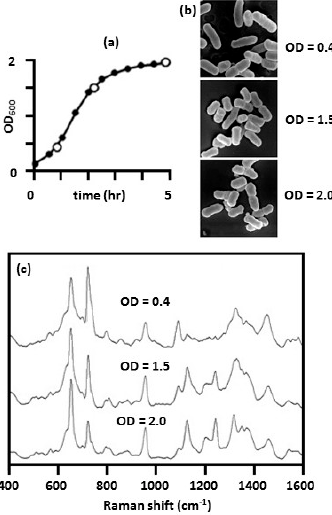
Figure 13. SERS spectra of E. coli obtained at different growth phases [55]: ( a ) plot of optical density at 600 nm (OD 600 ) as a function of growth time, where cells were harvested at OD 600 of 0.4, 1.5, and 2.0 (open circles); ( b ) SEM images of harvested bacteria; and ( c ) SERS spectra of harvested bacteria, where spectra were obtained by placing the bacteria on an Ag/AAO substrate and using 632.8 nm laser excitation. Reproduced with permission from the PLOS.